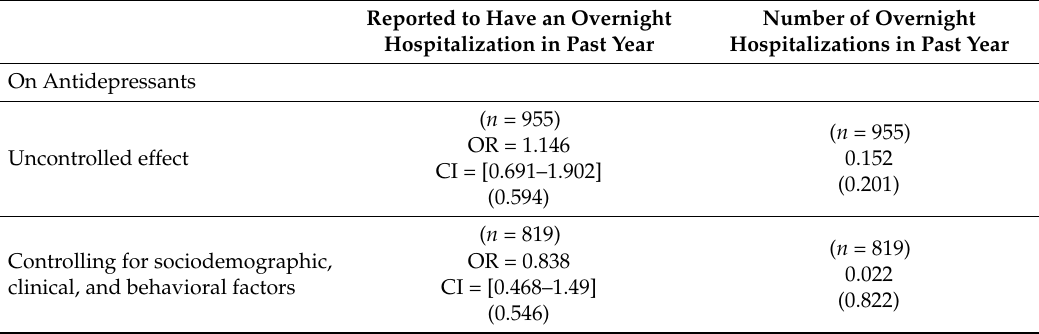
Table 7. Coefficients and levels of significance for the association between use of antidepressants and